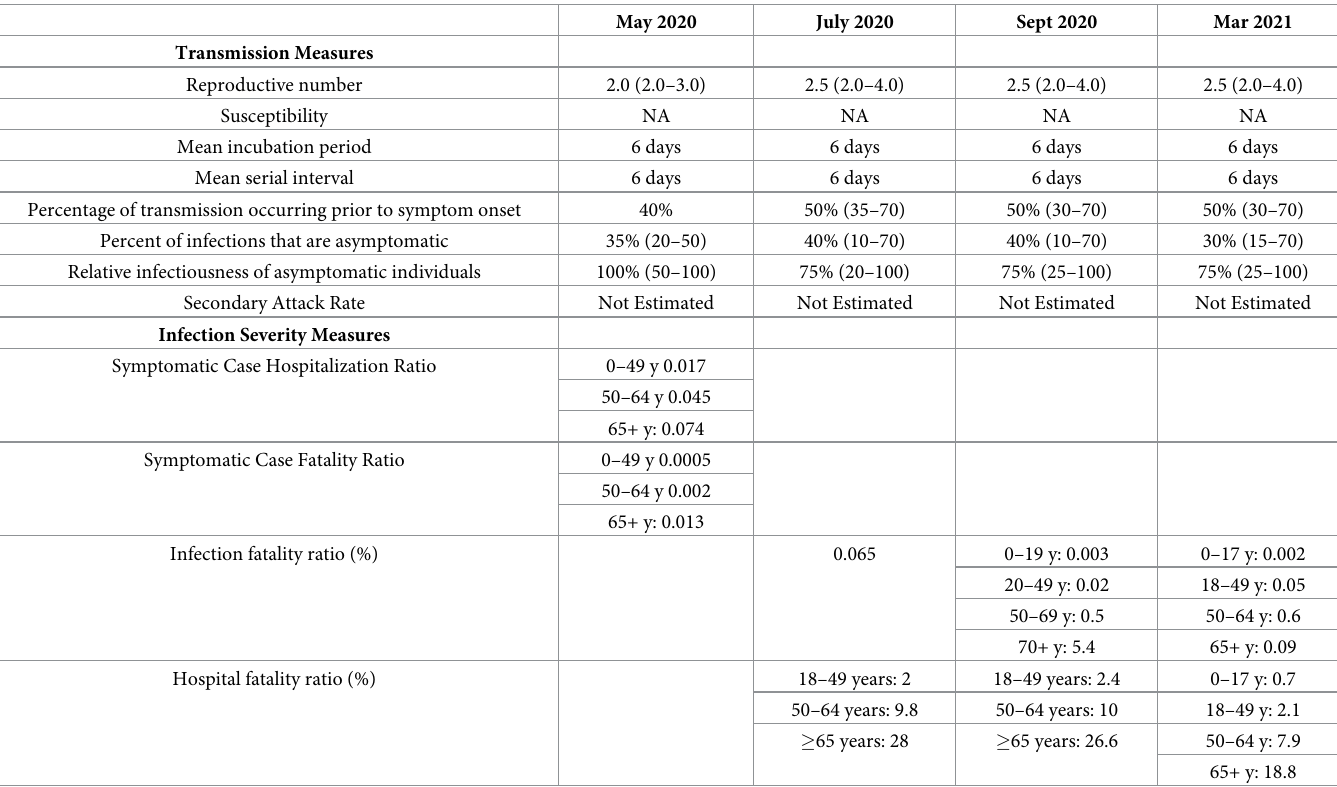
Table 2. USCDC estimates for COVID-19 selected infection transmission and severity